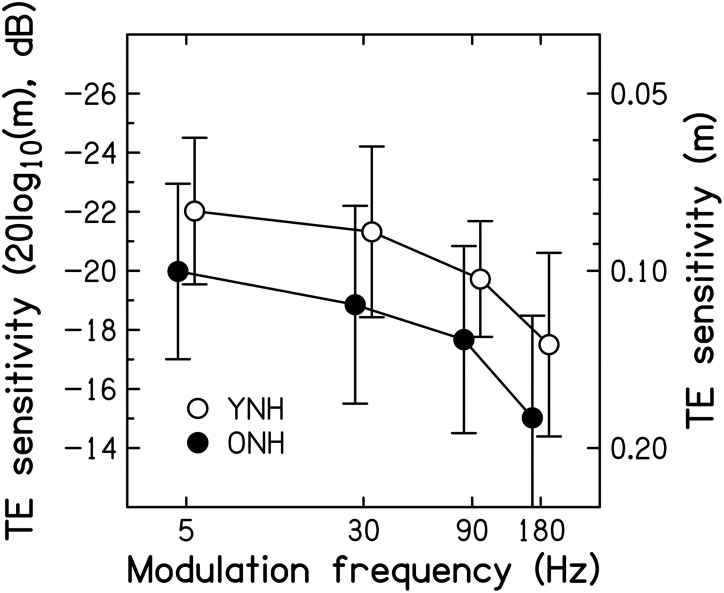
Thresholds for detecting SAM, expressed as 20log10(m) in dB on the left axis, and as m on the right axis, as a function of modulation frequency in Hz. Average thresholds for the YNH and ONH participants are indicated by the open and filled symbols, respectively. Error bars represent ±1 SD. Better sensitivity is toward the top of the figure.